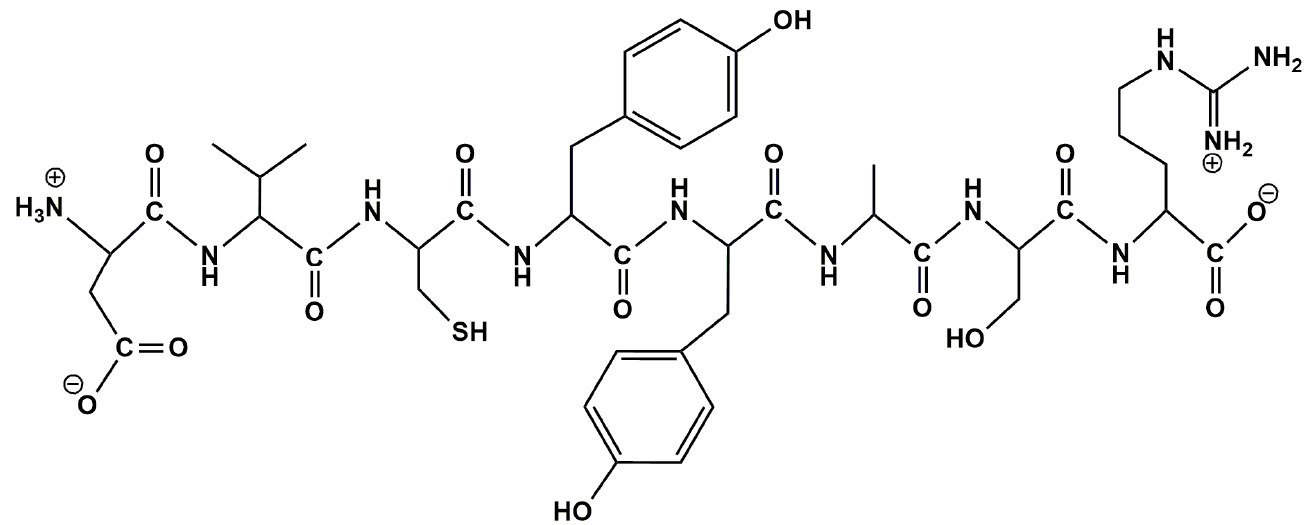
Figure 2. Chemical structure of peptide under study .